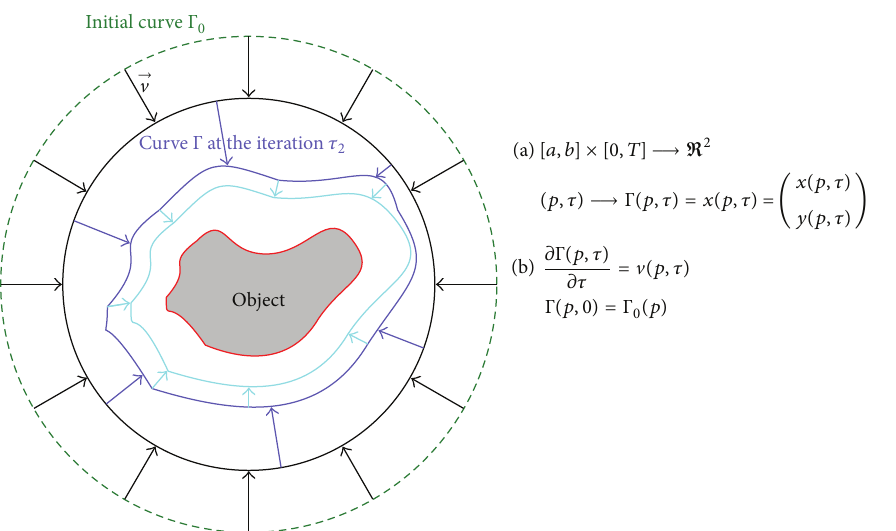
Figure 5: Illustration of active contour segmentation: Γ = Γ(𝑝,𝜏) denotes the coordinate of the point 𝑝 of the curve at iteration 𝜏 of the segmentation process.